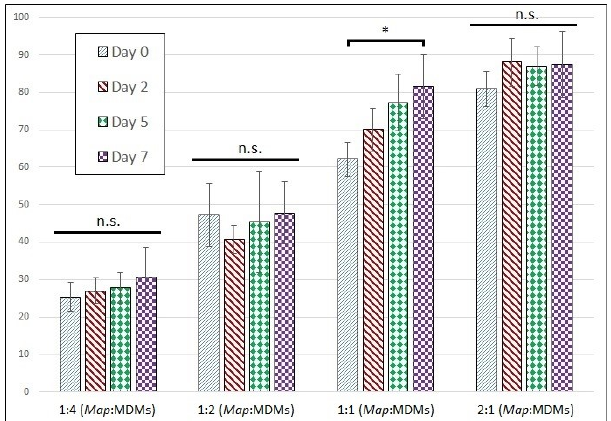
Figure 4. Proportion of infected MDMs remains stable across time-course. Proportion of infected MDMs with intracellular CFSE-stained Map expressed as a percentage of total cells. The bars are standard deviation. * p < 0.05; n.s. = not significant by student’s t-test (n =